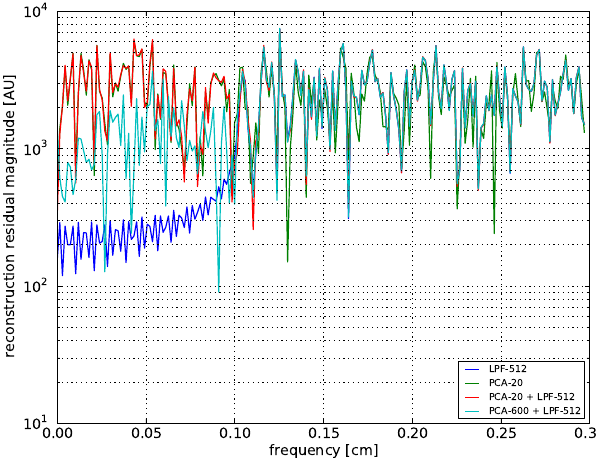
Figure 15. Spectrum of the reconstruction residual, i.e. the differ- ence between the processed and original spectra, for different noise suppression methods. Shown are only the low frequencies. The LPF subtracts high-frequency noise from the spectrum, which means that low-frequency noise modes are retained. The PCA method intro- duces no such bias. The combined PCA + LPF method introduces no noticeable bias as long as the number of principal components is kept small. Note that the abscissa is in spatial units; this is because it is the Fourier space associated with the wave-number